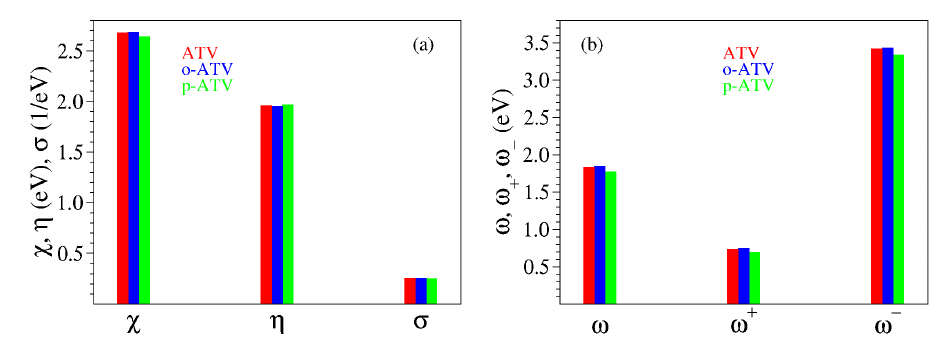
Figure 6. Global chemical reactivity indices defined by Equation (1) for atorvastatin and its ortho- and para-hydroxy metabolites: ( a ) electronegativity χ , chemical hardness η , and chemical softness σ ; ( b ) electrophilicity index ω , electroaccepting power ω + , and electrodonating power ω −